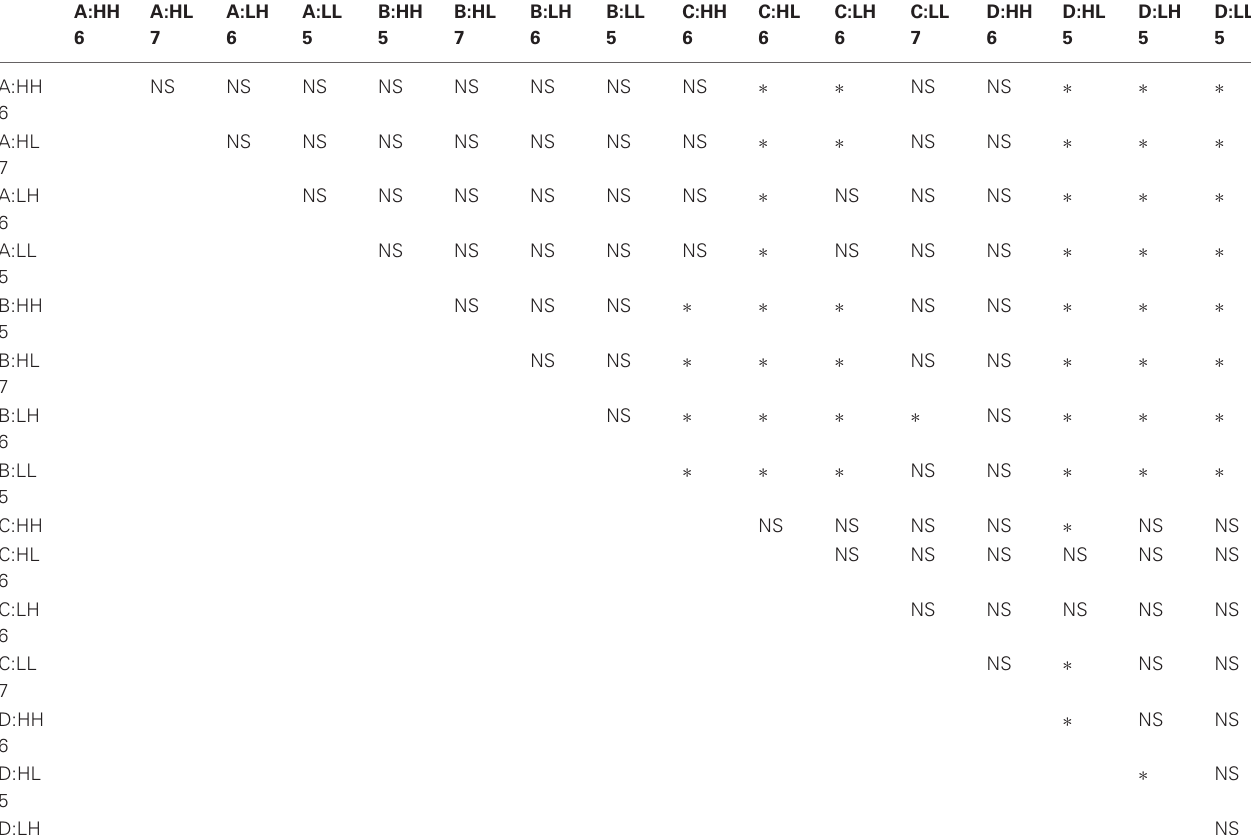
Table 3 | Tukey HSD comparisons of swimming velocities across all families and treatments.